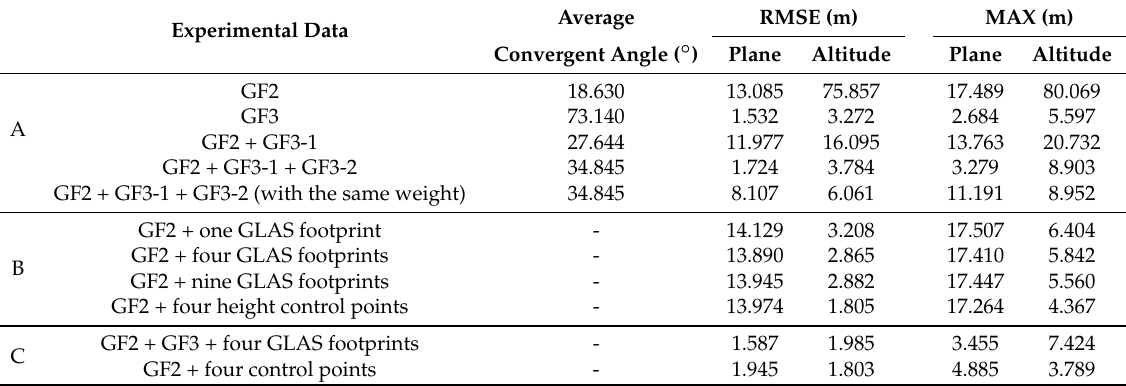
Table 5. Geometric accuracy of GF2, GF3, and GLAS combined